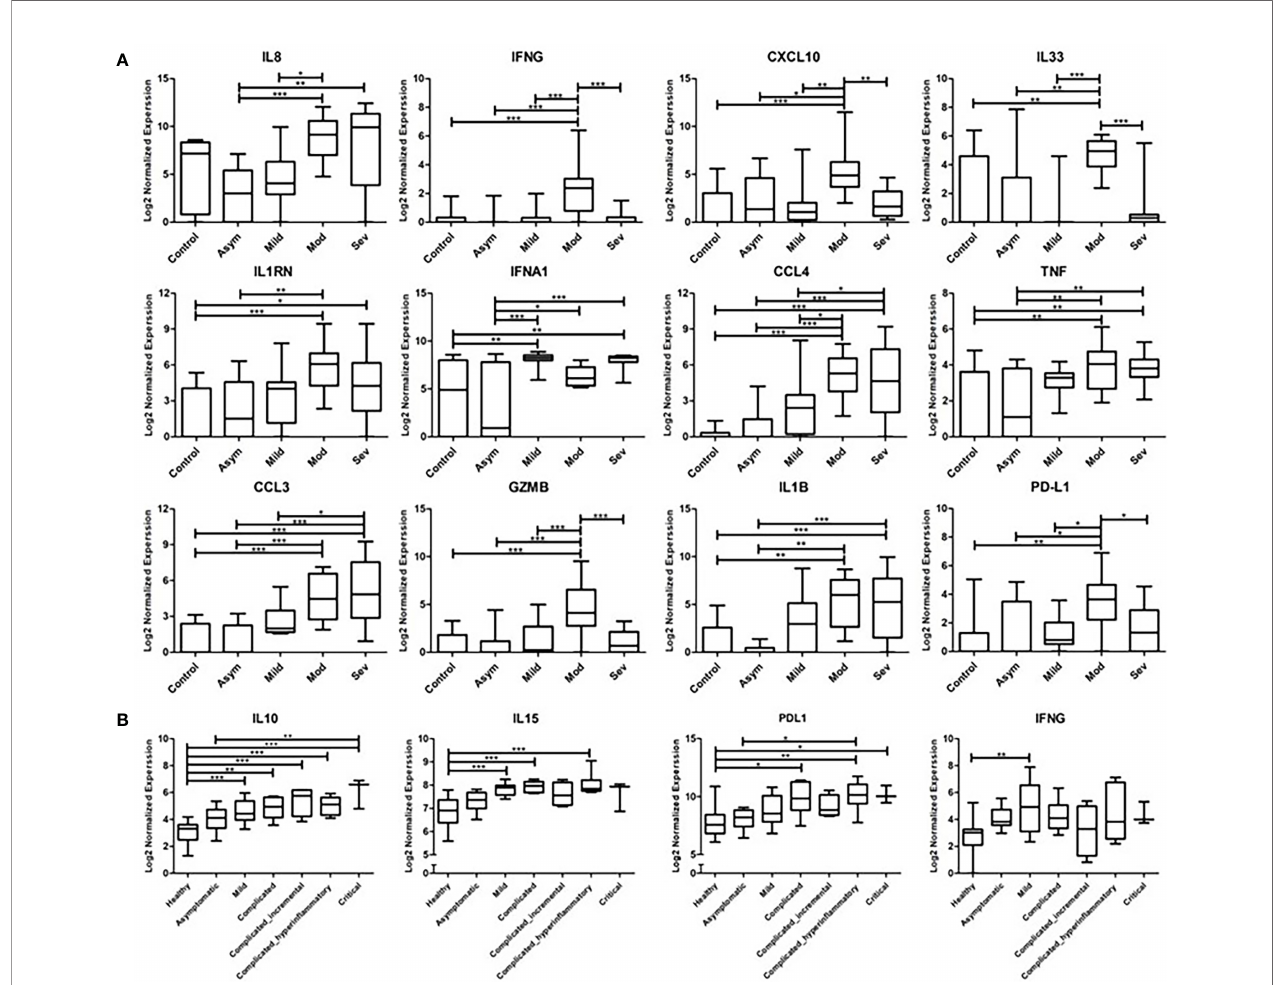
FIGURE 2 | Transcriptomics Analysis of nasopharyngeal swab samples and whole blood samples from COVID-19 patients. (A) Gene expression of cytokines and in fl ammatory mediators from the nasopharyngeal swap RNA-seq data compared across the different severity groups of COVID-19 cases (asymptomatic, mild, moderate, and severe) in reference to the non-COVID-19 control group. The data represented as log 2 normalized expression, where the normalized was performed using DESeq2 normalization approach across all the examined samples. (B) Gene expression of cytokines and in fl ammatory mediators from the whole blood RNA- seq dataset, compared across the different severity groups of COVID-19 cases (asymptomatic, mild, complicated, and critical) in reference to the non-COVID-19 control group. The data represented as log 2 normalized expression. * represents p-value < 0.05; ** represents p-value < 0.01; *** represents p-value < 0.001; analyzed using one-way ANOVA with post hoc Tukey ’ s multiple comparisons